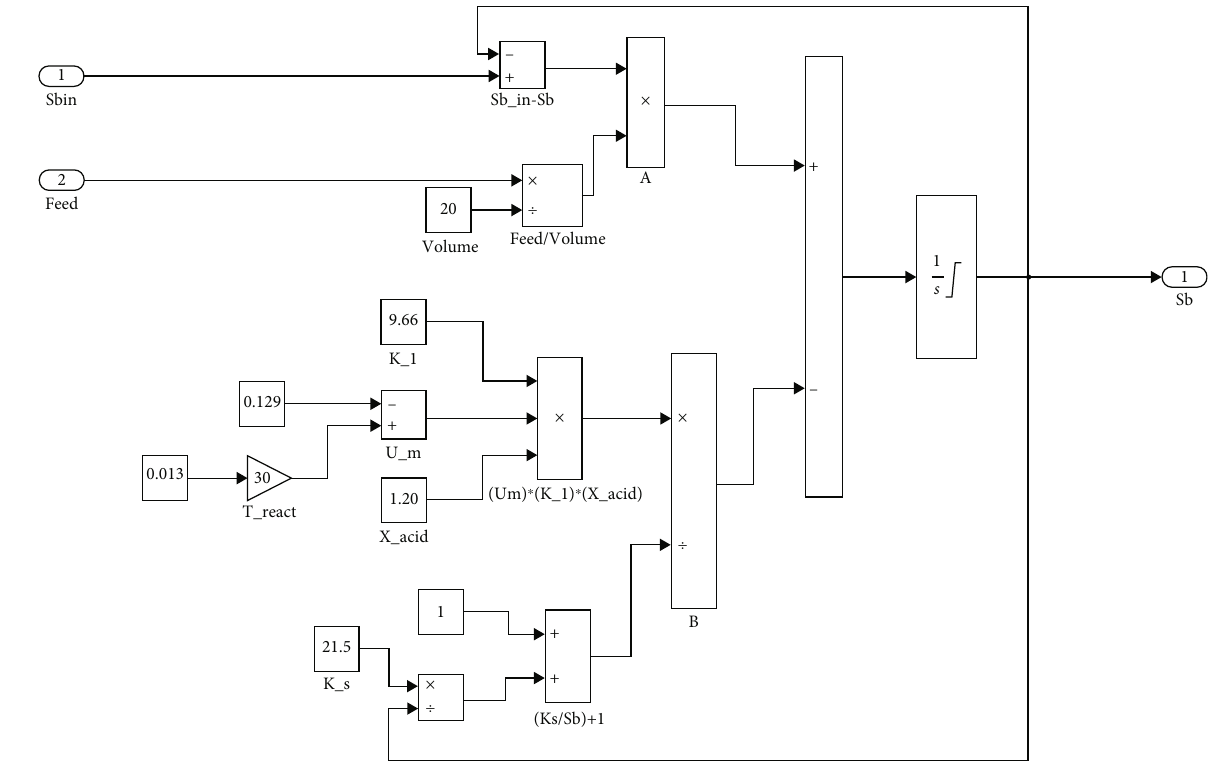
Figure 3: Simulink model of